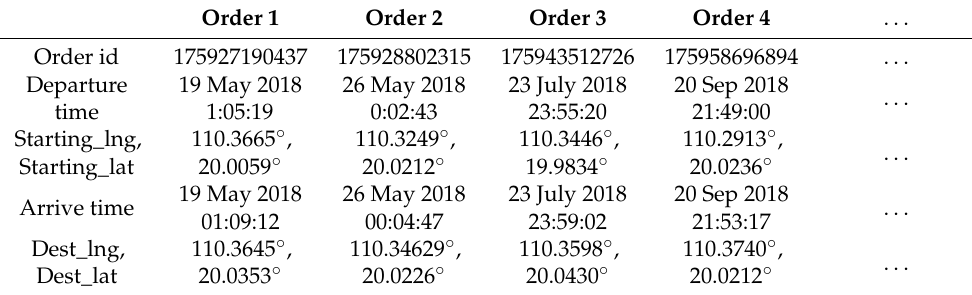
Table 2. Statistics of the taxi order datasets.